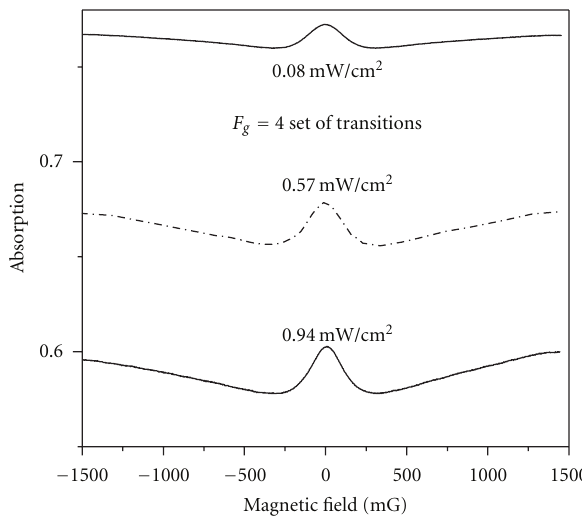
Figure 5: CPT bright resonance profile with light intensity, at the F g = 4 set of transitions. The conventional cell is at room tempera- ture ( T = 22 ◦